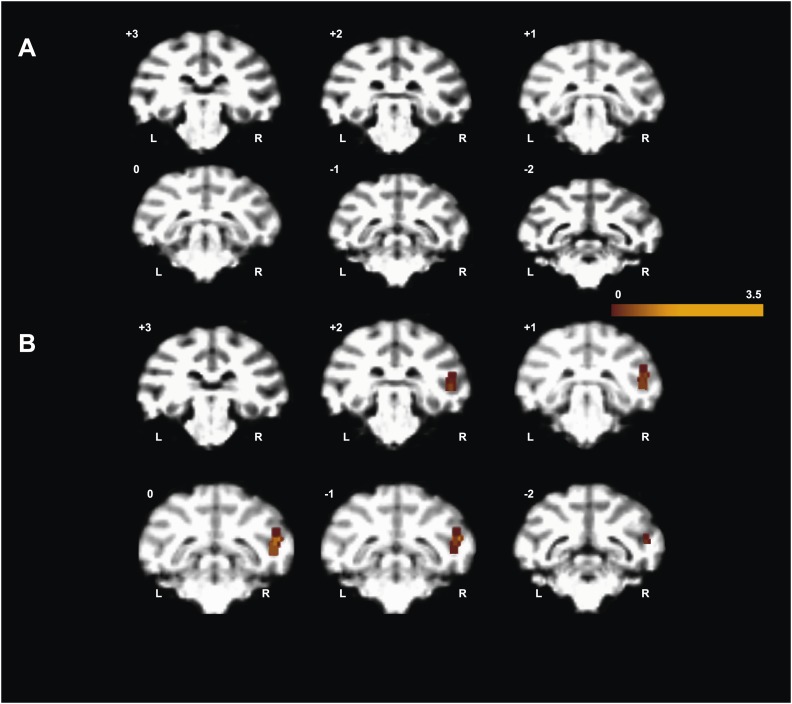
'Gaze following vs identity matching' BOLD contrast evoked in Experiment 1 using a unilateral small coil placed on the left hemisphere of M1.Coronal sections based on T1 weighted anatomical scans cut through the brain M1 with significant BOLD responses mapped onto the sections. (A) Absence of significant activity at a significance level p<0.005, uncorrected, 5 contiguous voxel. (B) Significance level p<0.05, uncorrected, 5 contiguous voxels. The numbers in the left corner of each section indicate the AP-distance from interaural plane of the monkey. Notice that the BOLD response is contralateral to the position of the coil. L = left, R = right.